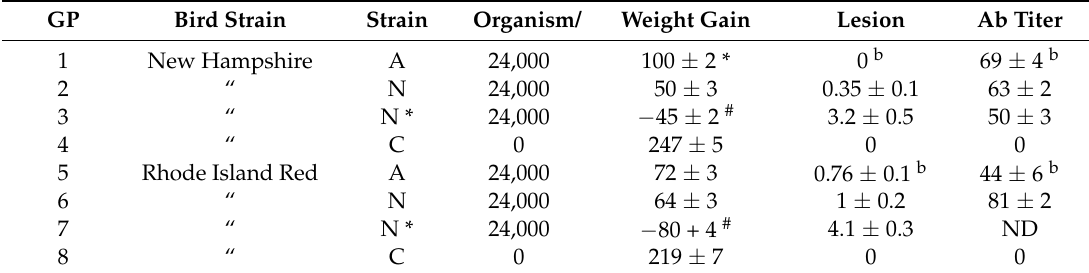
Six birds/group were immunized with 240 and 2400 Normal (N) or Aberrant (A) organisms (weeks 2 and 4) with 2-weeks interval. Control (C) animals received (0) sham inoculation. Infected control group (N *) received no previous immunization before final challenged inoculum. Lesion scores. Mean Body Weight gain/g